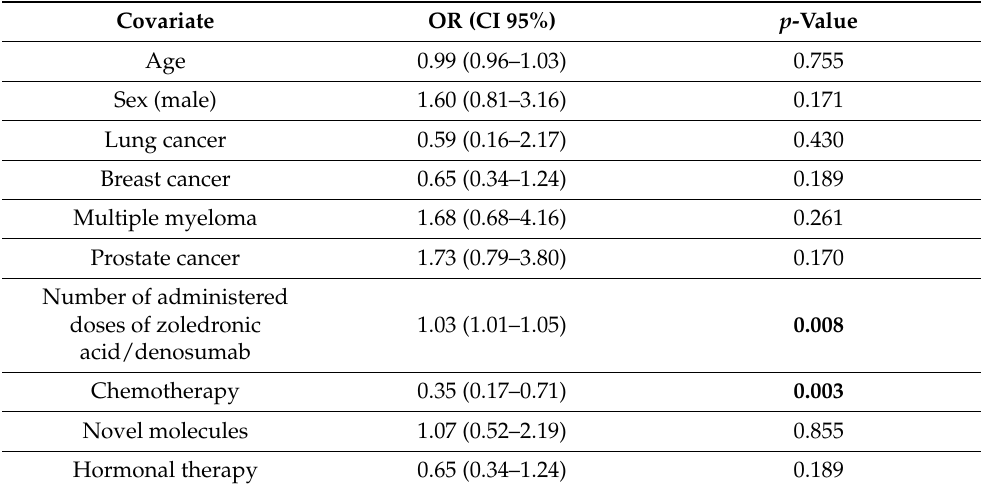
Table 3. Logistic regression model to identify potential predictors of risk of MRONJ in cancer patients.